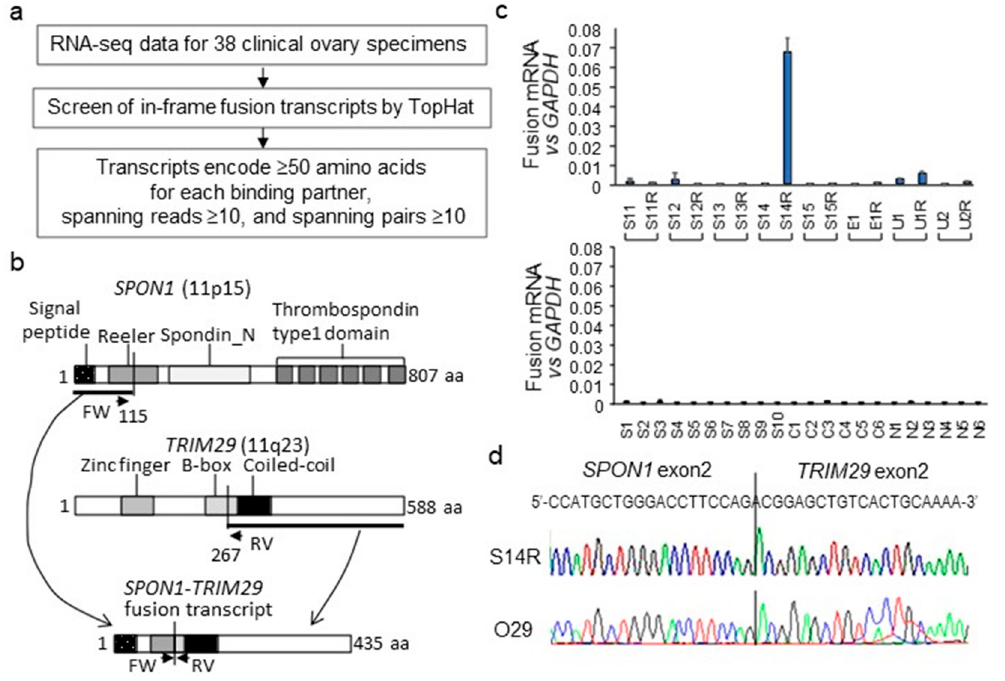
Figure 1. Identification of SPON1-TRIM29 fusion transcript in ovarian cancer by RNA-seq. ( a ) Schematical presentation of strategies to identify fusion transcripts in ovarian cancers by RNA-seq. ( b ) Schematic presentation of the putative SPON1-TRIM29 fusion protein translated from the SPON1-TRIM29 fusion transcript in which the SPON1 exon2 is fused in-frame to the TRIM29 exon2. SPON1 and TRIM29 proteins are represented with their domain structures. Primers for specific amplification of SPON1-TRIM29 fusion mRNA in RT-qPCR are indicated as arrows (FW and RV). ( c ) Expression levels of SPON1-TRIM29 fusion transcript in 38 clinical ovary specimens analyzed by RT-qPCR. cDNA samples prepared from clinical specimens were amplified using primer sets that span the fusion point. Upper panel for 8 matched pairs of primary and recurrent ovarian cancer specimens. Lower panel for 10 high-grade serous carcinomas (HGSC, #S1–S10), 6 clear cell carcinomas (CCC, #C1–#C6), and 6 normal ovary tissues (#N1-N6). The mRNA levels of SPON1-TRIM29 fusion transcript are normalized with GAPDH and the data are presented as means ± SD ( n = 3). ( d ) Chromatograms for Sanger sequencing results for SPON1-TRIM29 fusion transcript in tumors #S14R and #O29.